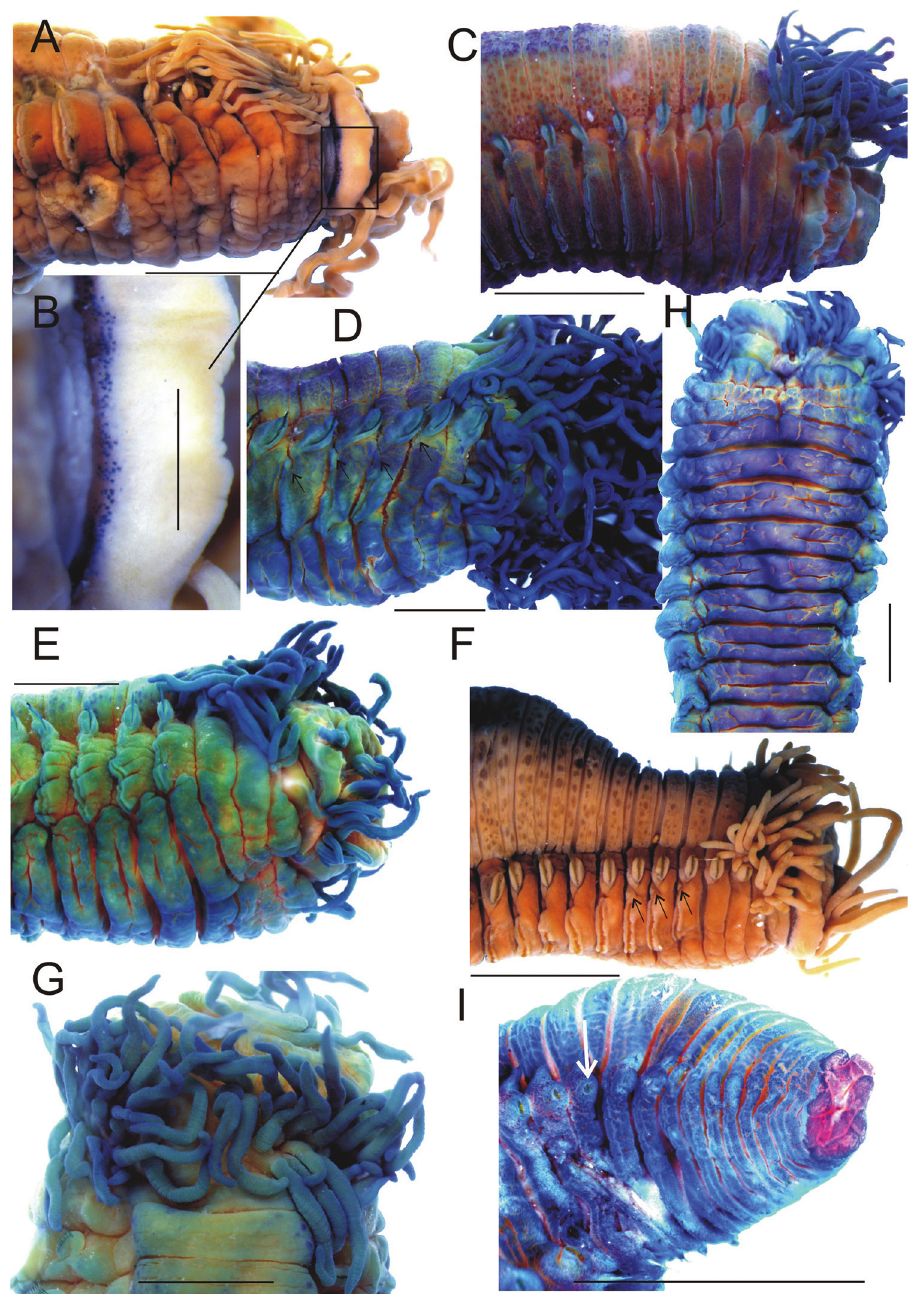
Figure 2. Thelepus cincinnatus external morphology . A, C–I lateral view of anterior end B detail, show- ing eyespots G dorsal view of anterior end H ventral view of anterior end I lateral view of posterior end (arrow indicates last segment with notochaetae). A, B, F, I Alaid st. 30.13 C Alaid st. 8 D, E, H, G Alaid st. 6. All worms except A, B, F stained with methylene blue D, F arrow indicates nephridial papillae. Scale bars: 2 mm except B 0.5